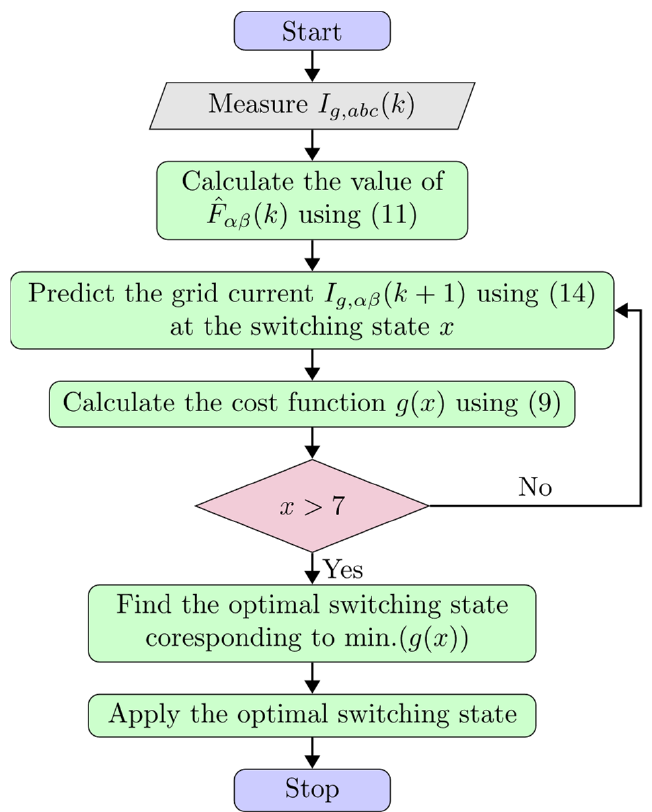
Figure 7. Flowchart of the proposed MFPC for the grid current control.